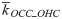
Effect of the Y-shaped structure formed by outer hair cell, Deiters cell and Deiters cell phalange.(A) The outer hair cells (red elements) tilt toward the basal direction while the Deiters cell phalanges (thin green elements) tilt in the opposite direction. Thus, they form repeating Y-shaped structures that behave like a truss structure. (B) To investigate the effect of the Y-shaped structure, either the tilt was set to zero (‘No tilt’ condition) or the Deiters cell phalanges were removed (‘No DCp’ condition). (C) The elastic reactance to the outer hair cell, k¯OCC_OHC, increased by removing the tilt (‘No tilt’) or by increase the mechanical properties of the Deiters cell, its phalange and the reticular lamina (‘Stiff OCC’). k¯OCC_OHC decreased when there was no Deiters cell phalange. (D) The cochlear amplification was affected by the Y-shaped structures and the stiffness of the Deiters cell phalange.